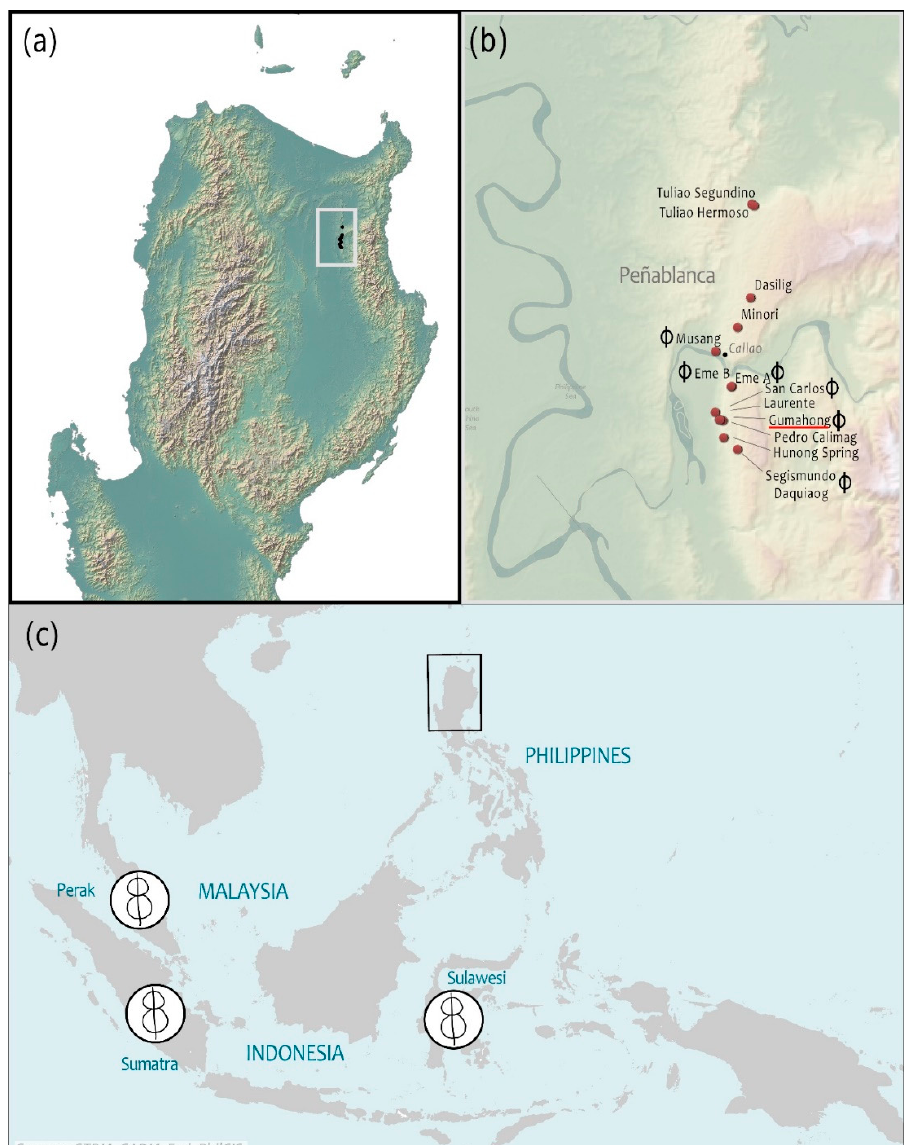
Figure 6. Map of ( a ) northern Philippines with study area highlighted in grey; ( b ) Peñablanca rock art sites with Gumahong underlined in red and sites with circle motif marked; and ( c ) Southeast Asia showing where similar motifs are located. Background map created by Maria Kottermair.